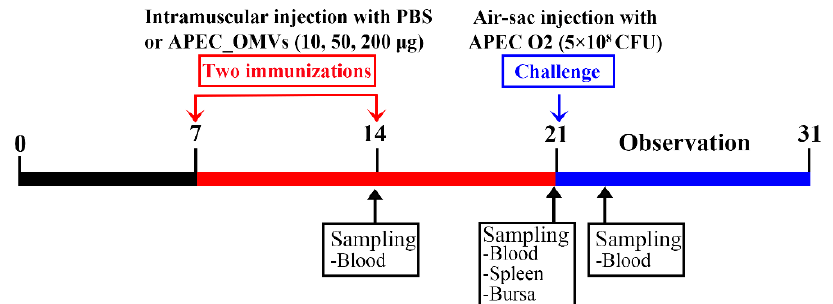
Figure 3. Timeline of APEC_OMV vaccination and bacterial challenge in broiler chick experiments. Four groups of broiler chicks (n = 30; 6 replicates per group with 5 birds per replicate) were intramuscularly immunized with PBS (as a control) and various doses of APEC_OMVs at 7 and 14 days of age, respectively, and challenged by the air sac route at 21 days of age. Blood and spleen samples were collected from PBS- and APEC_OMV-immunized chicks at indicated times.